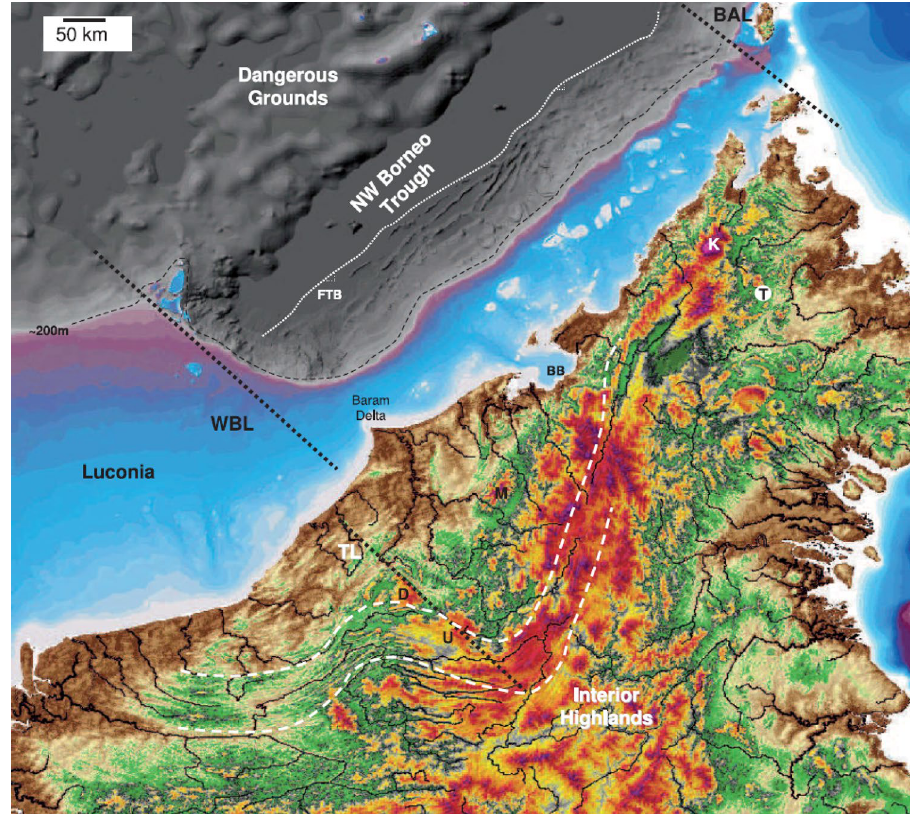
Fig. 1 Overview of the geo- provinces of the NW Borneo displayed on bathymetric map and Shuttle Radar Topogra- phy Mission Digital Elevation Model. BB Brunei Bay, D Dulit Plateau, FTB fold and thrust belt, K Mt. Kinablalu Pluton, M Mulu, T Telupid ophiolite, WBL West Baram line, TL Tinjar line, BAL Balabac line, U Usun Apau volcanic plateau (adapted from Cullen